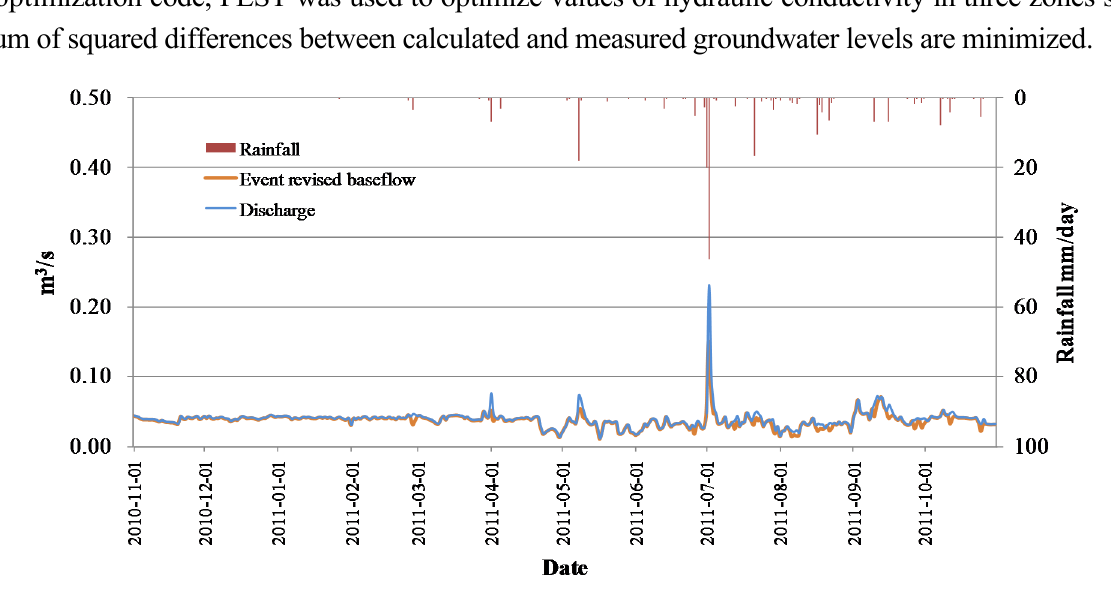
Figure 8. Relations among the observed discharge, separated baseflow, and the rainfall in the Bulang